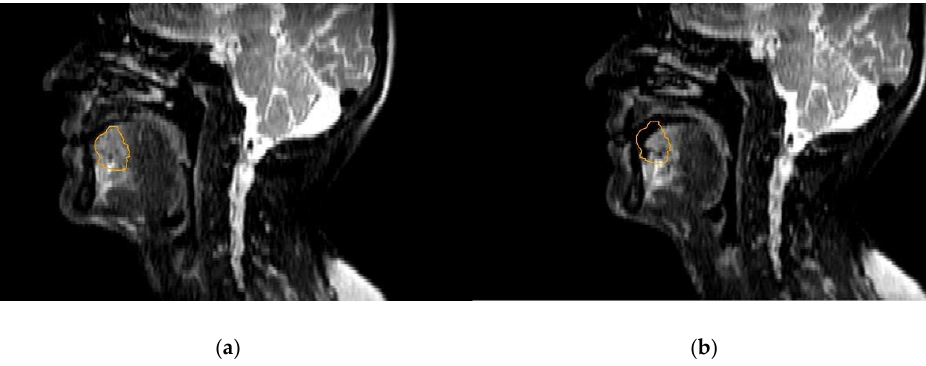
Figure 3. A patient with a metastasis in the tongue that was treated with 6 × 6 Gy on an MR-Linac. The picture showing the difference in GTV position (orange) on T2w 3D TSE SPAIR pre (a) (left) and post (b) treatment (interval between scans 23 min).